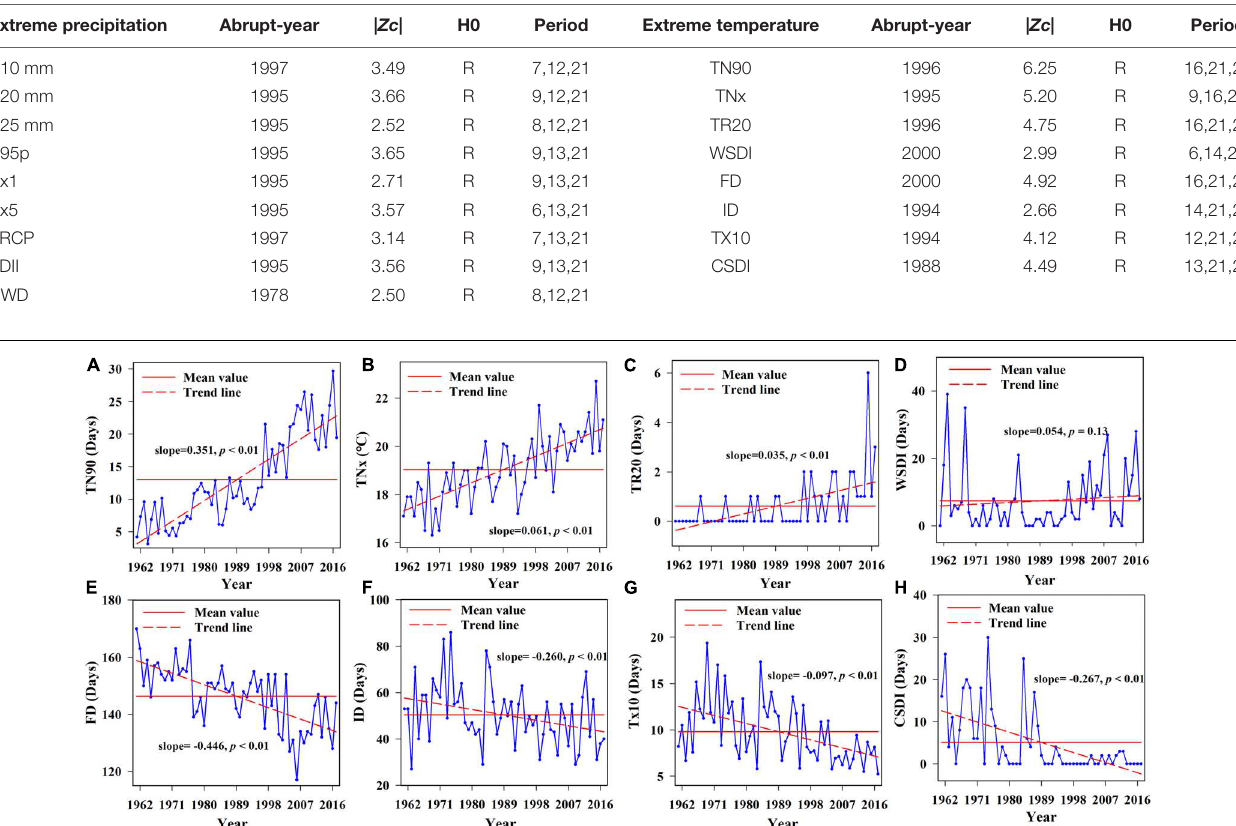
TABLE 1 | Results of abrupt-change test and period of all extreme indices.